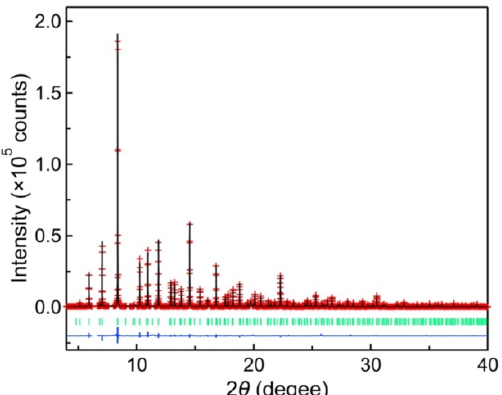
Figure 3. Result of Rietveld refinement of SXRD data for the S-2 sample prepared by reducing twice with Mg at 1000 °C for 10 h with λ = 0.419839(1) Å. The red crosses, black line, blue line, and green dashes denote, respectively, the observed, calculated, difference intensities, and Bragg positions.